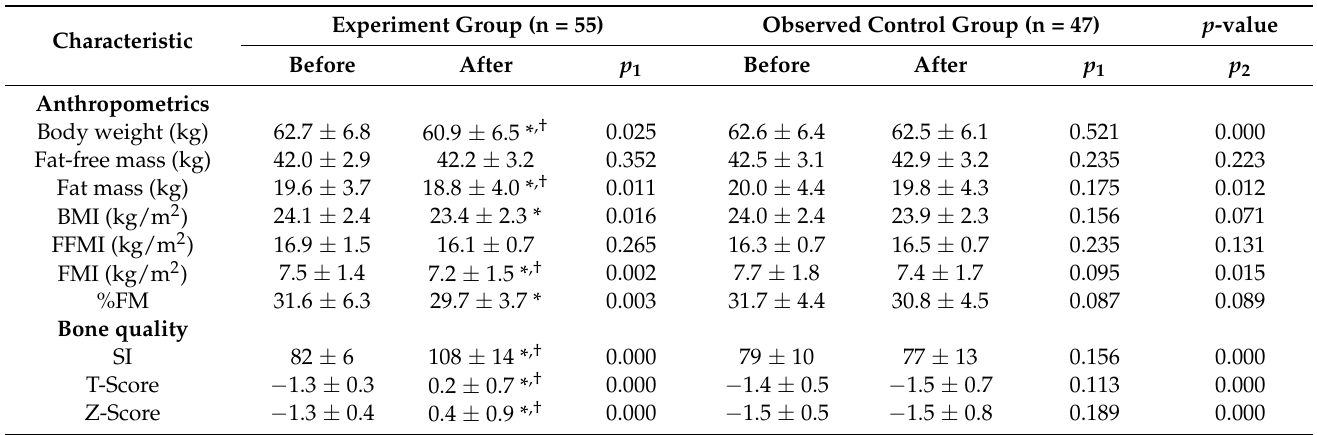
Table 3. Changes in anthropometric and bone